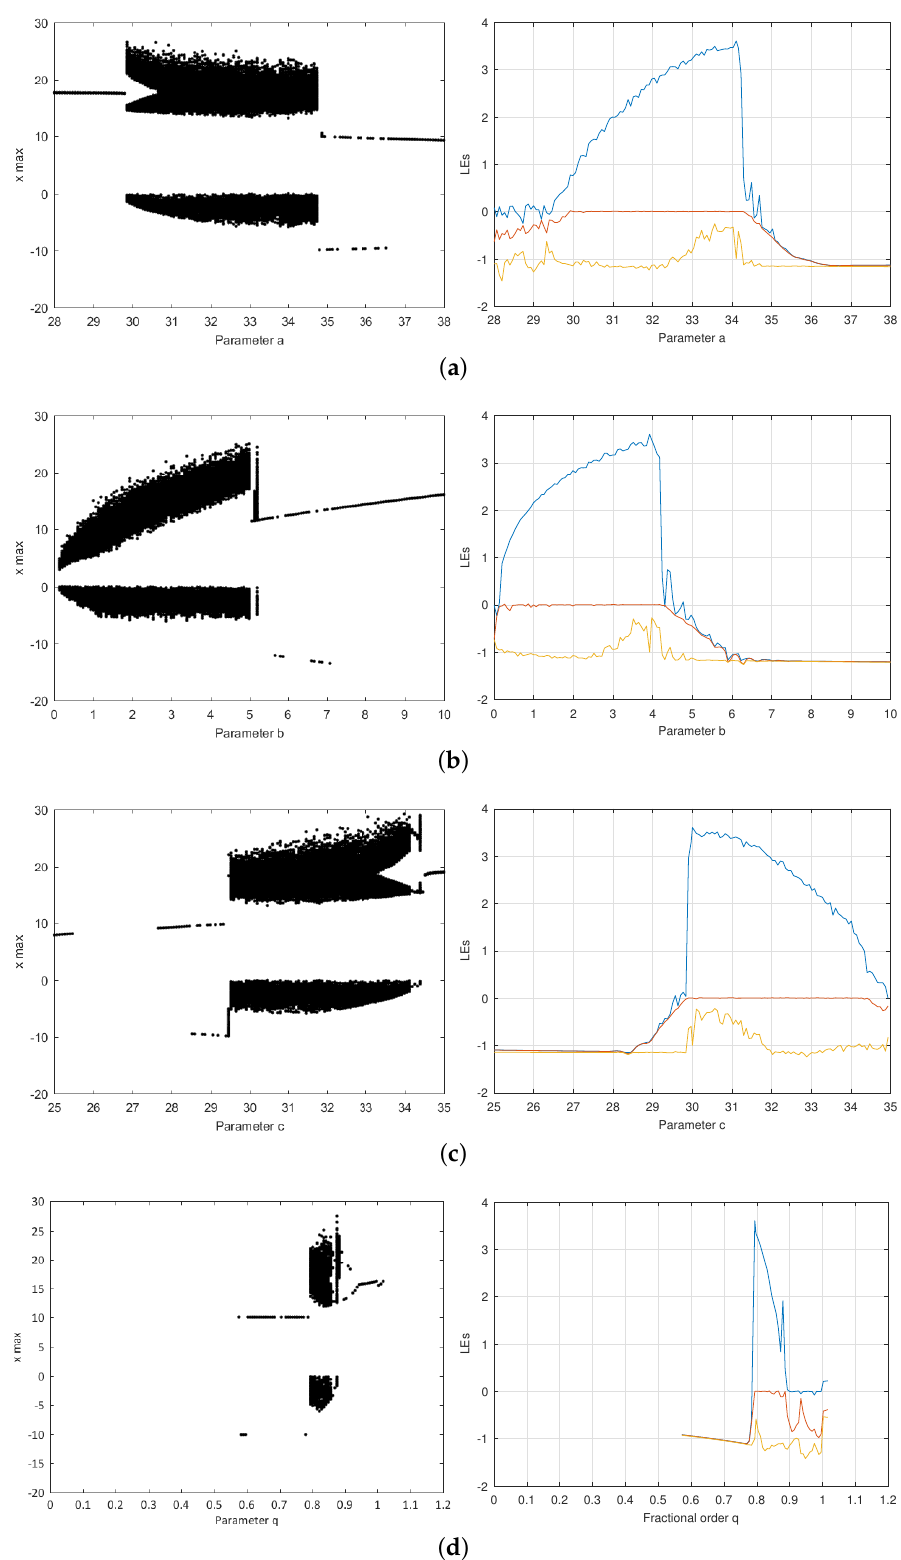
Figure 6. Bifurcation diagram and LE spectra of fractional order Chen system for IWO best result at 450 and 500 generations. For the LE spectra, L 1 is in blue color, L 2 in red, and L 3 in yellow. a = 34.1050, b = 3.9198, c = 30.0000, q = 0.7933 and MLE = 3.6070. ( a ) Parameter a ( b ) Parameter b ( c ) Parameter c ( d ) Fractional order q